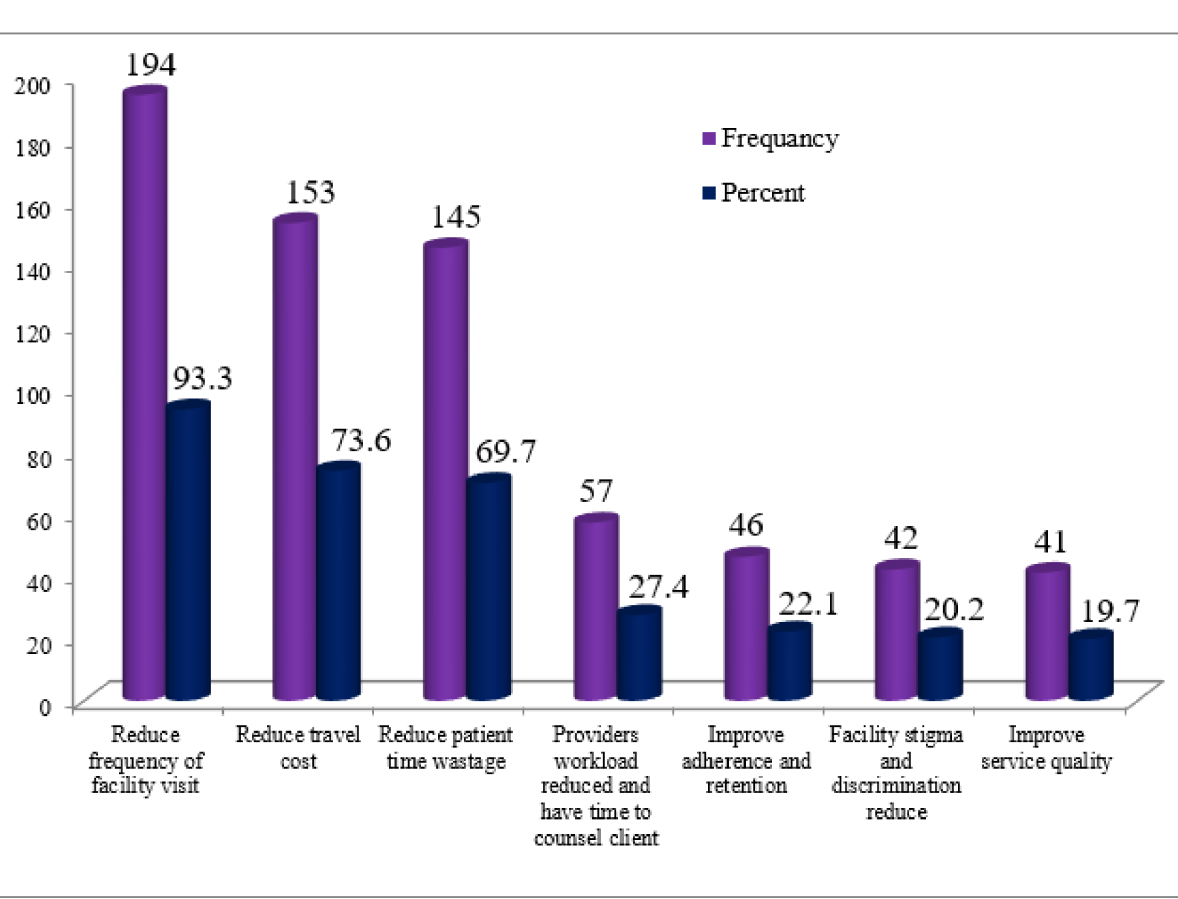
Fig 2. Reasons for uptake of ASM among stable clients on antiretroviral therapy in East Gojjam Zone, Amhara, Northwest Ethiopia, 2020 (n = 208).